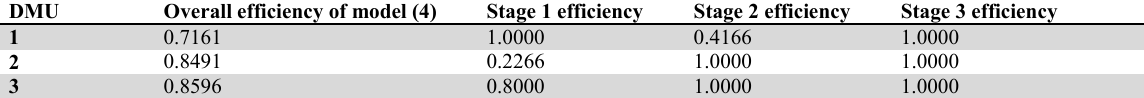
Numerical results for nonlinear models (6) to (9), without linearization for data in Table 5 DMU